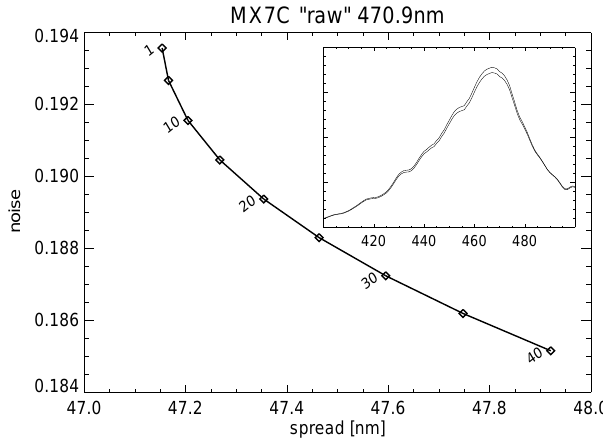
Figure 8. Backus–Gilbert tradeoff curve with inverse relationship between resolution function spread and retrieval error. Results were obtained using MX7C “raw” kernels with a retrieval wavelength of 470.9nm and µ ranging from 1 to 40. Inset shows nearly indistin- guishable resolution functions for µ = 1 and µ = 40.